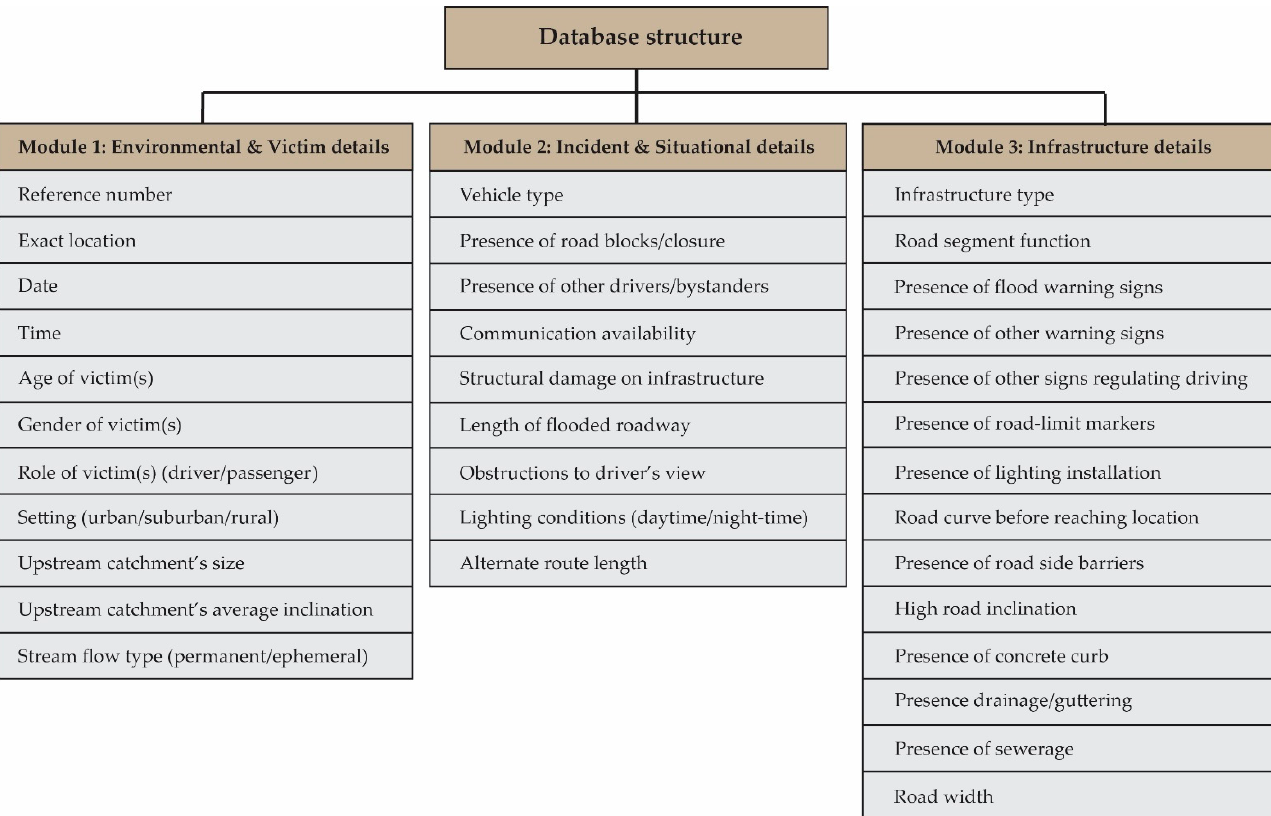
Figure 1. Structure of the database in three modules and the elements included. Table 1. Sources of flood fatality information (1960–2020), with details of the type of information provided by each source.